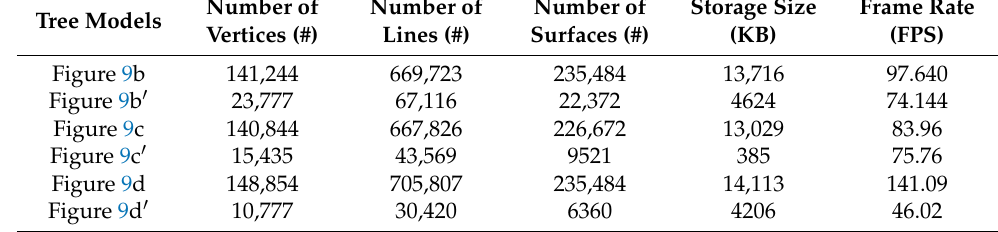
Figure 9d (cid:48)